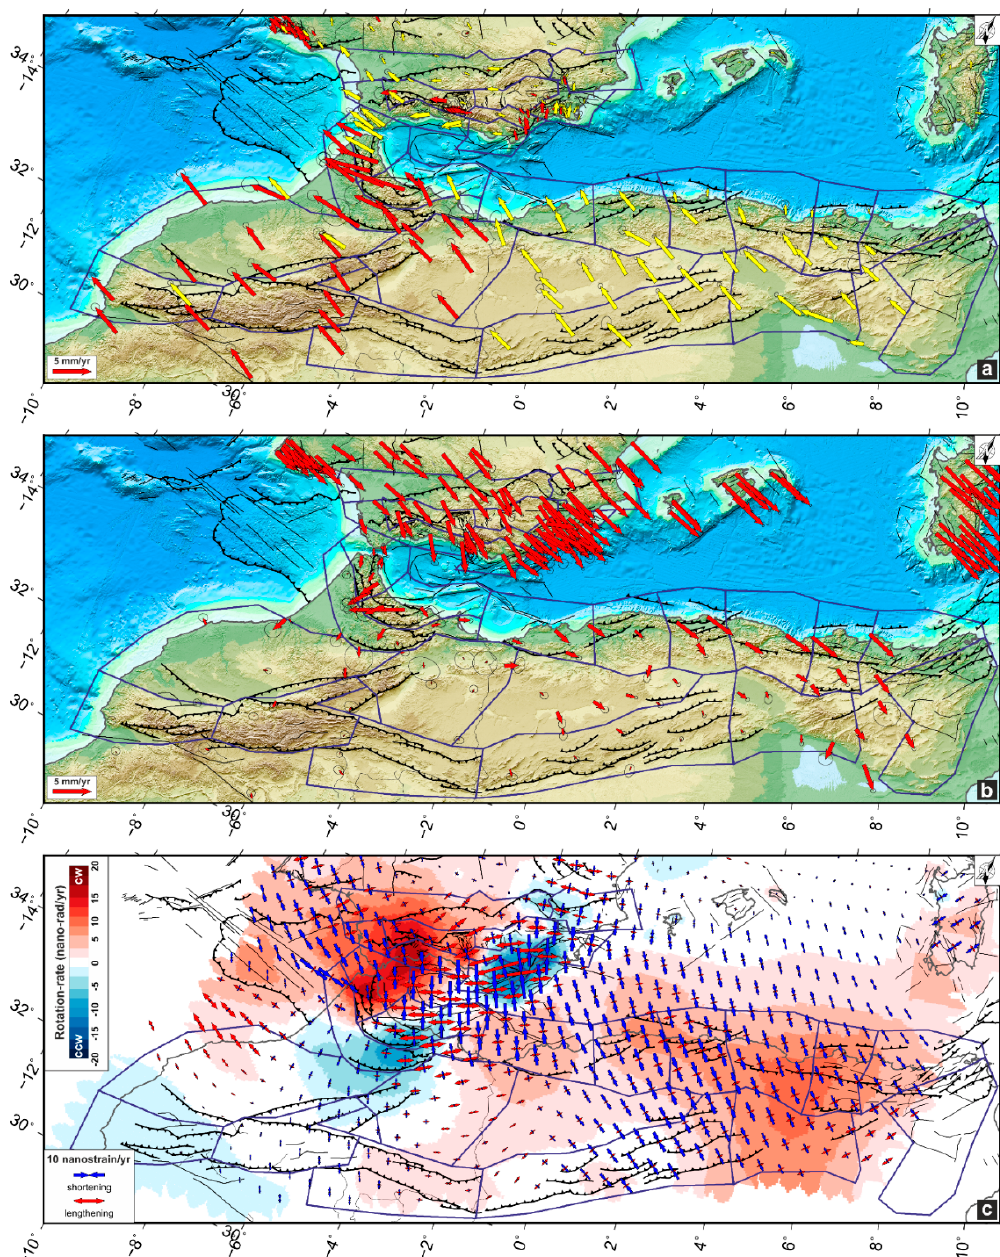
Figure 3. Global Navigation Satellite System (GNSS) velocities and 95% confidence ellipses in a fixed ( a ) Eurasian and ( b ) Nubia reference frame (see Table S1 in the Supplementary Material section). Continuous and episodic GNSS stations are reported as yellow and red arrows, respectively. ( c ) Geodetic strain-rate field: red and blue arrows represent the greatest extensional ( ε Hmax ) and contractional ( ε hmin ) horizontal strain-rates, respectively; the colors in the background show the rotation strain-rate (which describes the rotations with respect to a downward positive vertical axis with clockwise (cw) positive and counterclockwise (ccw) negative, as in normal geological conventions). The map is plotted in an oblique Mercator projection.